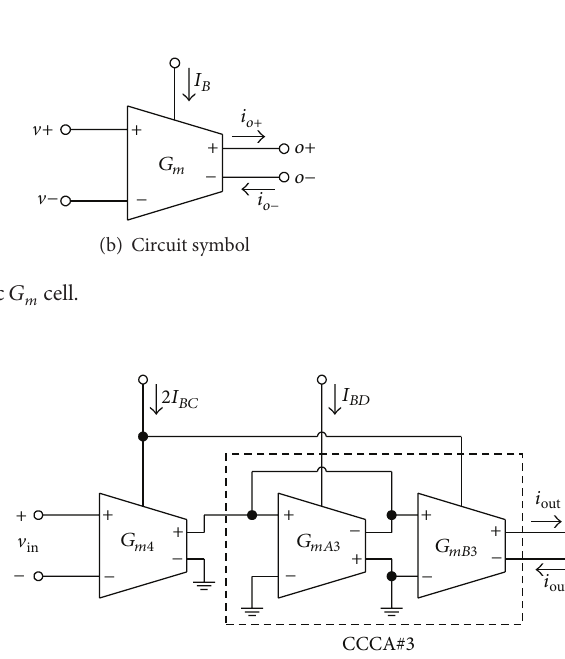
Figure 5: Linearly tunable transconductance amplifier